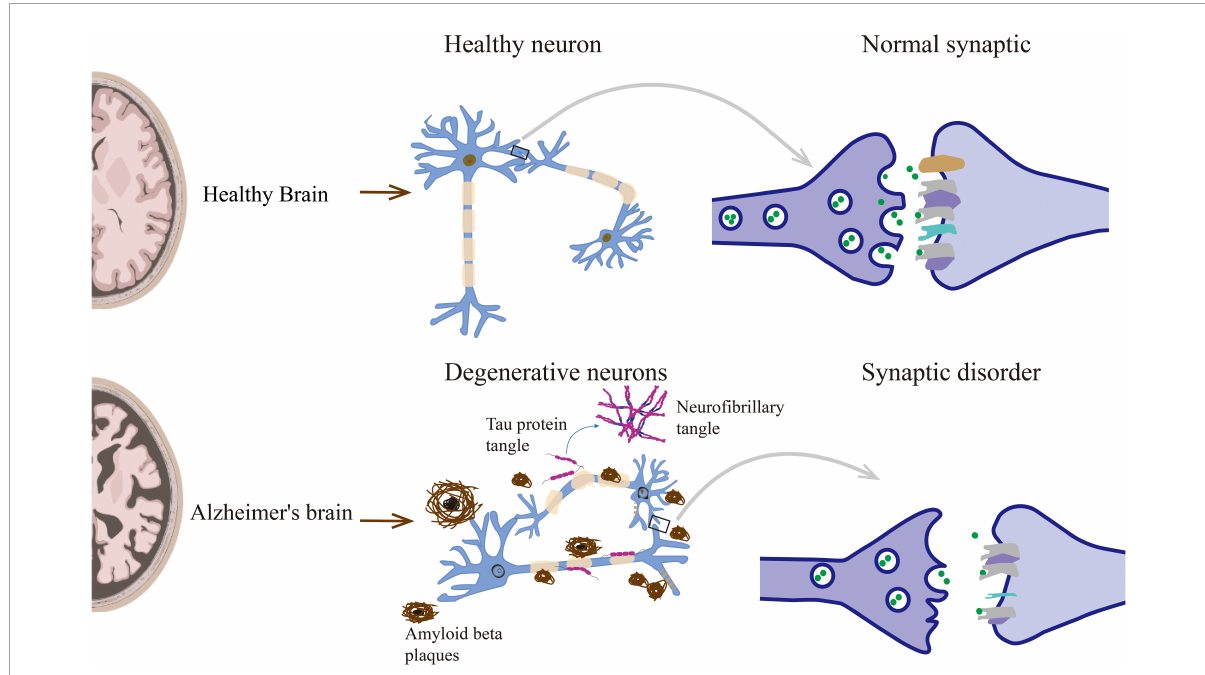
FIGURE1 Neuropathological lesions in Alzheimer’s disease include senile plaques, neurofibrillary tangles, and other causes leading to synaptic